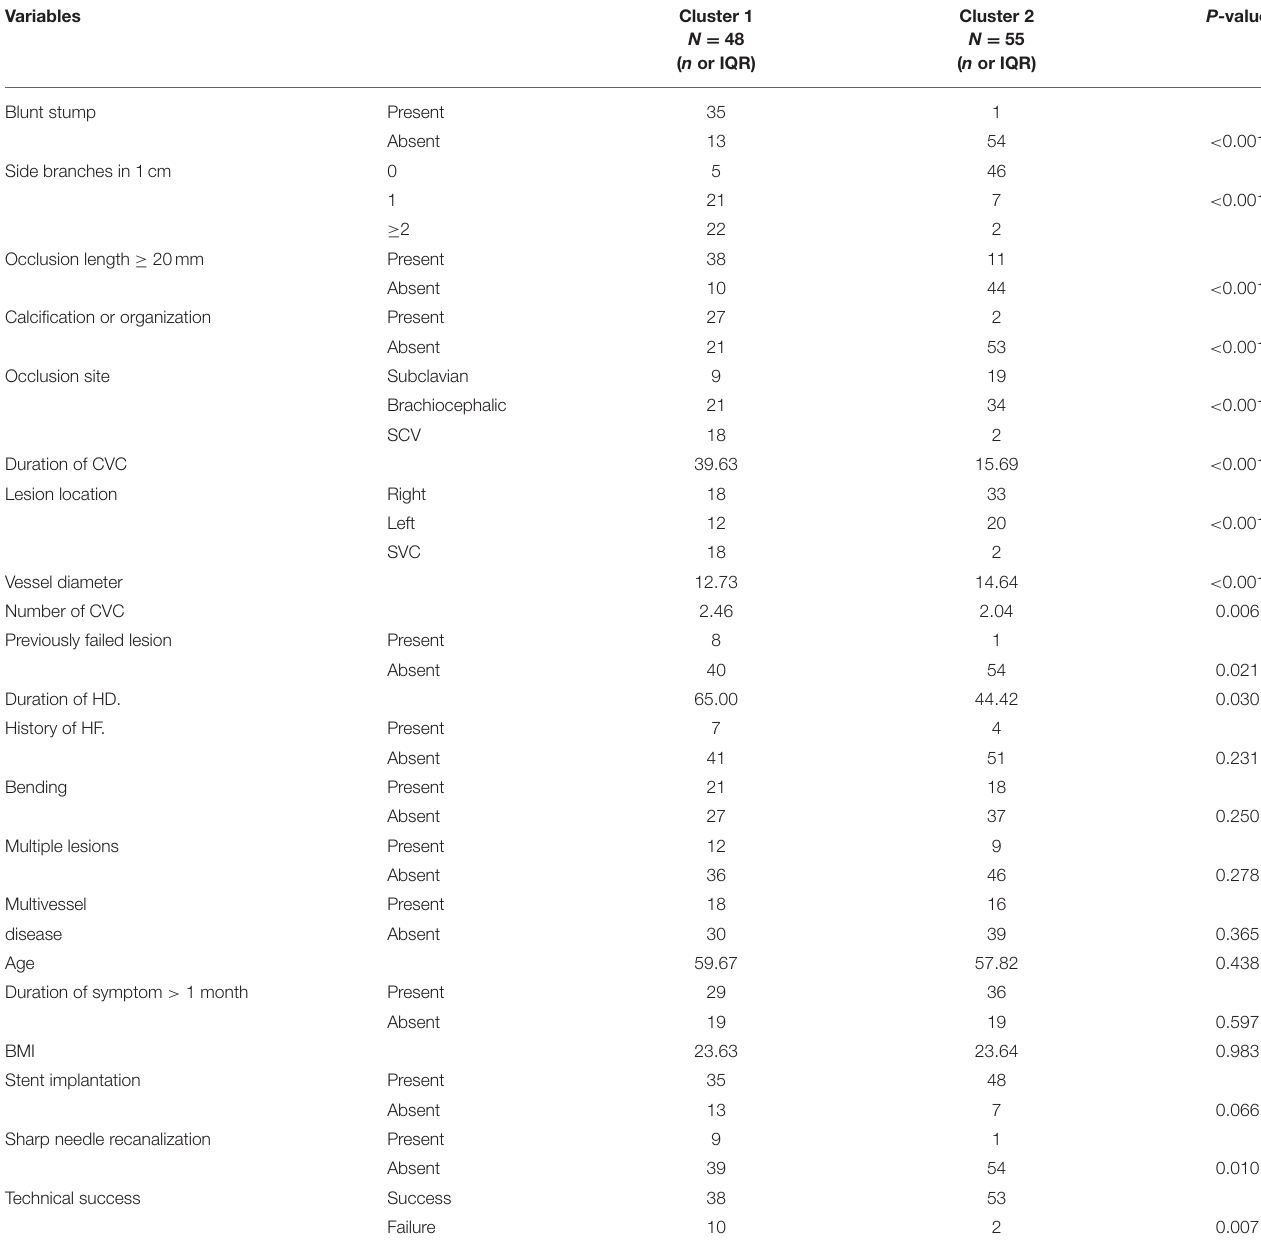
TABLE 2 | Comparison of characteristics in two